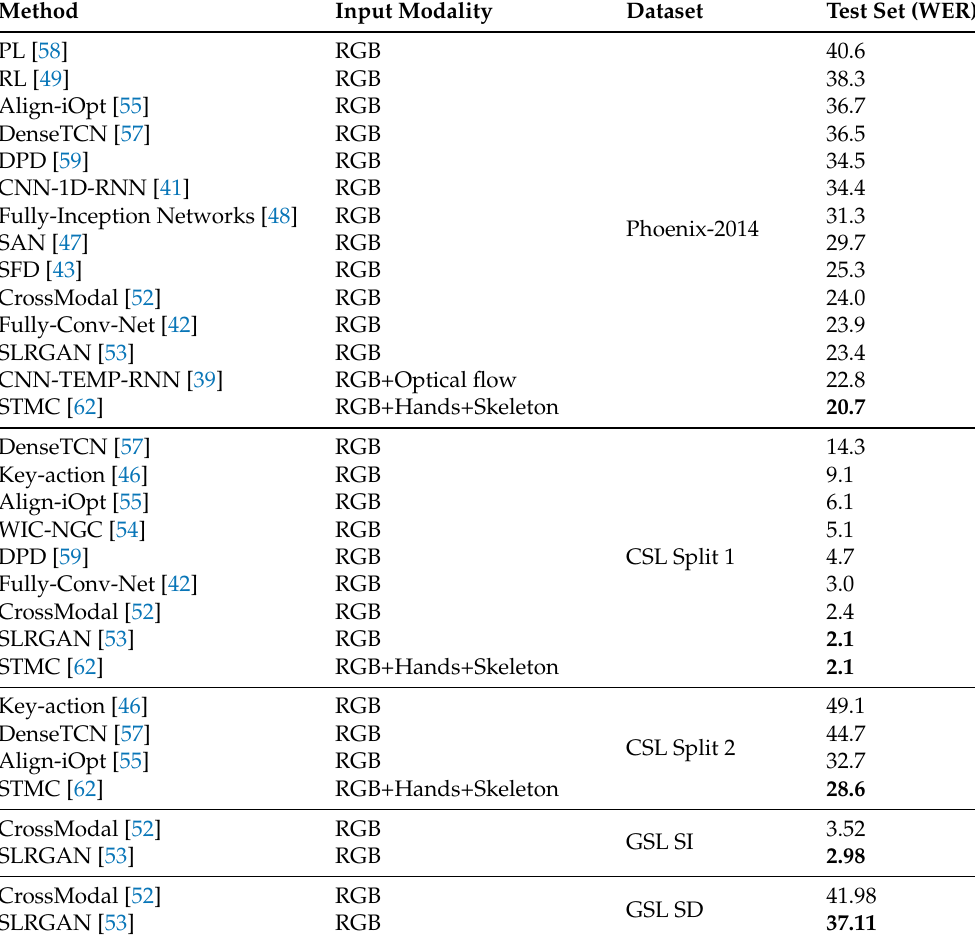
Table 2. Performance comparison of CSLR approaches categorized by dataset measured in WER (%). The best performance for each dataset appears in